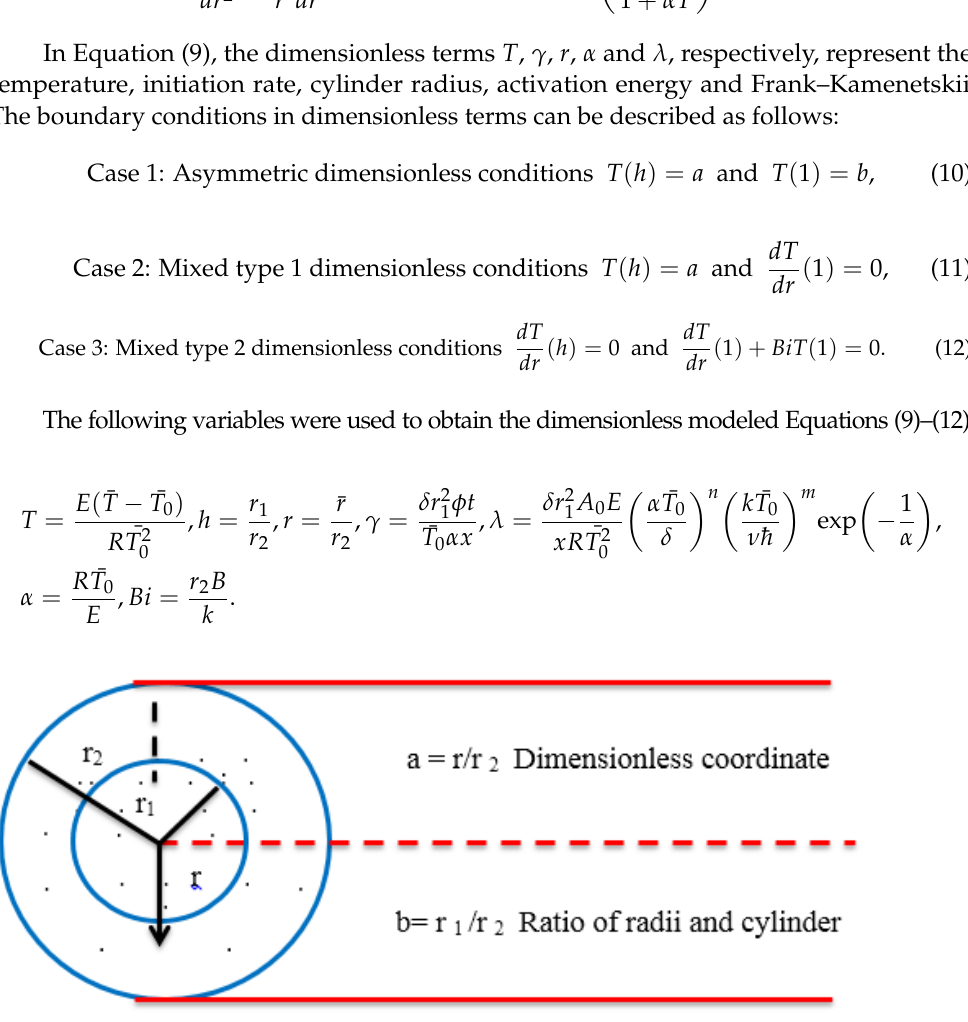
Figure 1. Reaction species coordinate